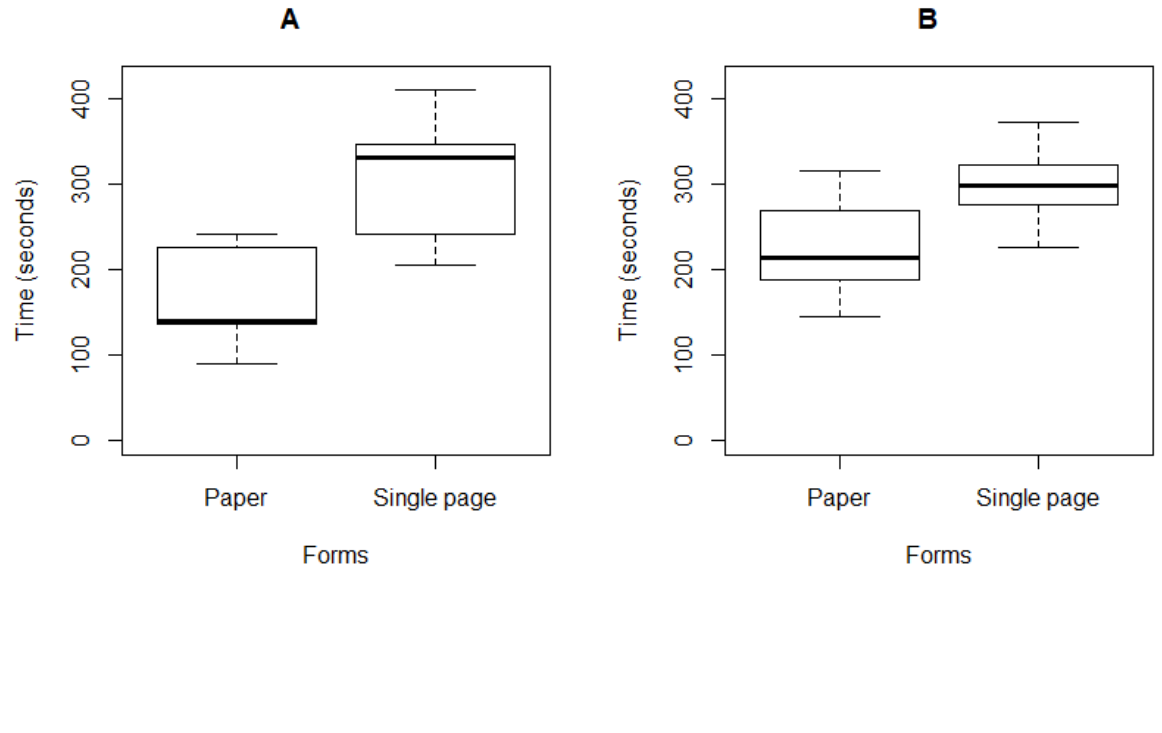
Figure 10. Boxplot for the average form completion time of activators versus research nurses. (A) Activator nurses’ form completion time and (B) research nurses’form completion